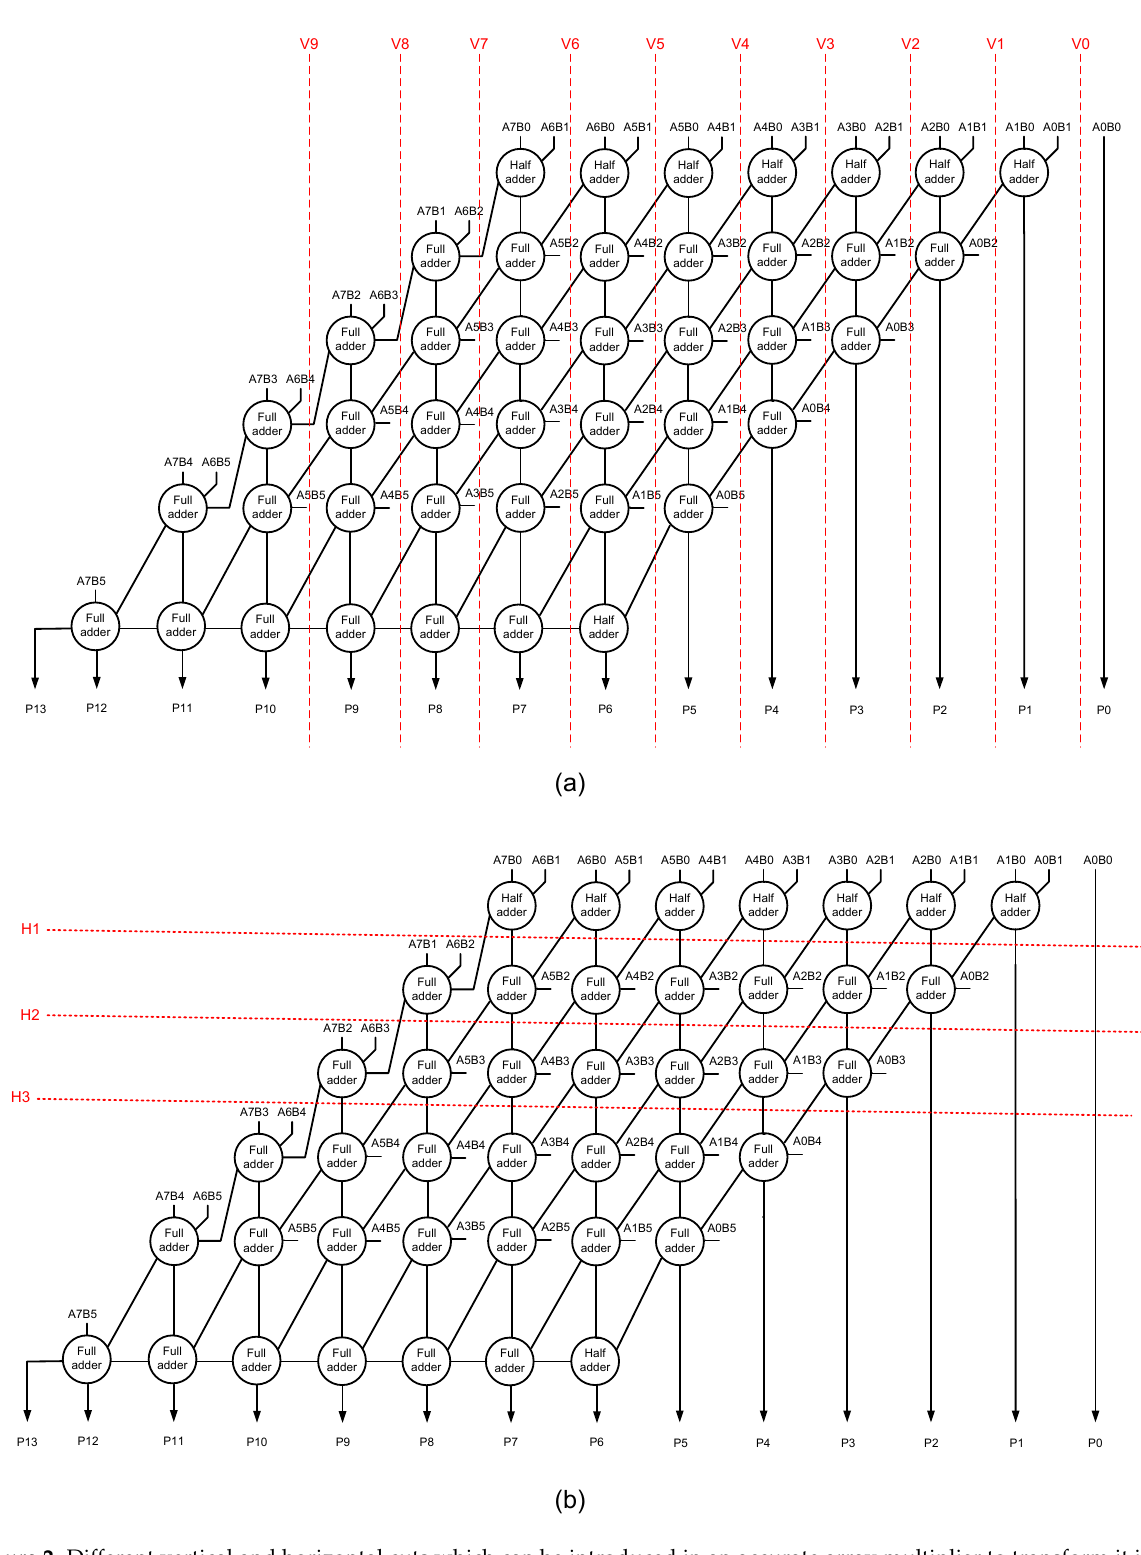
Figure 2. Different vertical and horizontal cuts which can be introduced in an accurate array multiplier to transform it into approximate array multipliers. ( a ) Some vertical cuts; ( b ) some horizontal cuts.